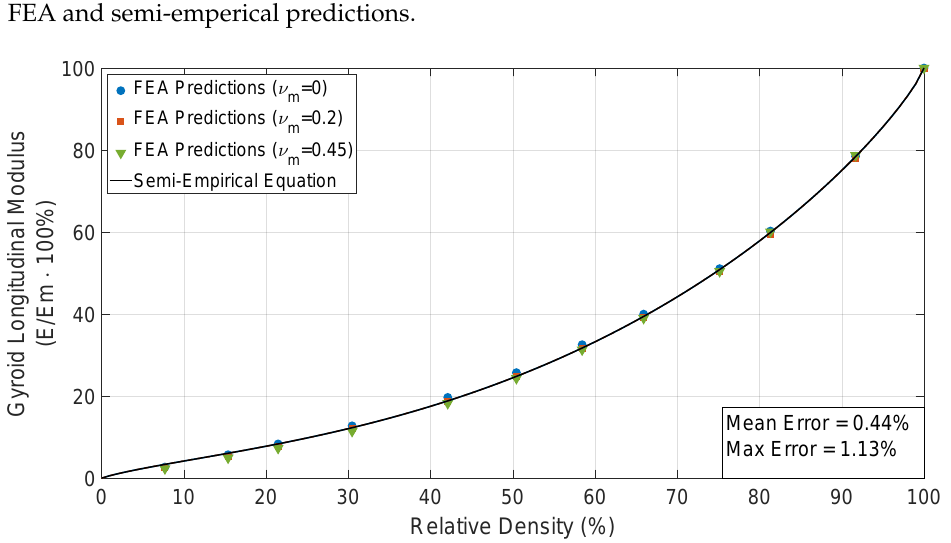
Figure 13. FEA predictions vs. semi-empirical equation for longitudinal modulus.